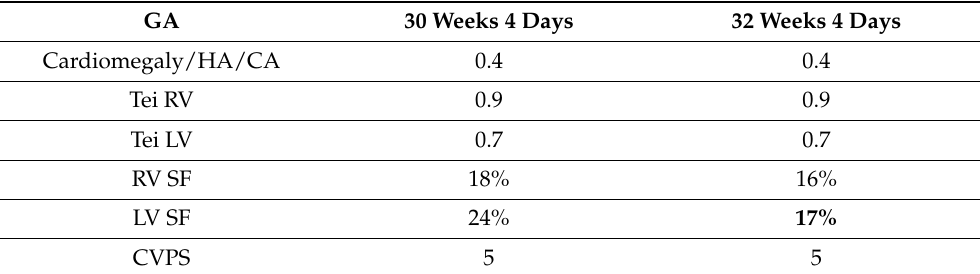
Table 1. Standard selected echocardiographic parameters analyzed in the present case indicating the progression of fetal heart failure.